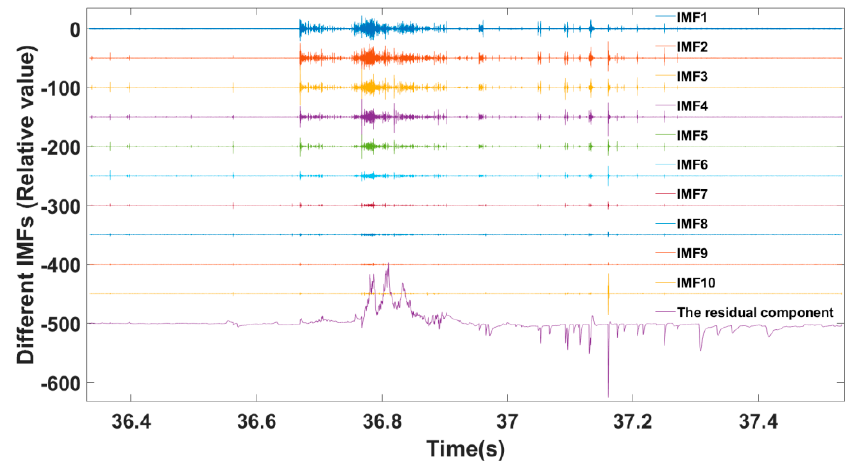
Figure 3. Different components of station MD obtained by the EMD decomposition method for IC flash 001136.